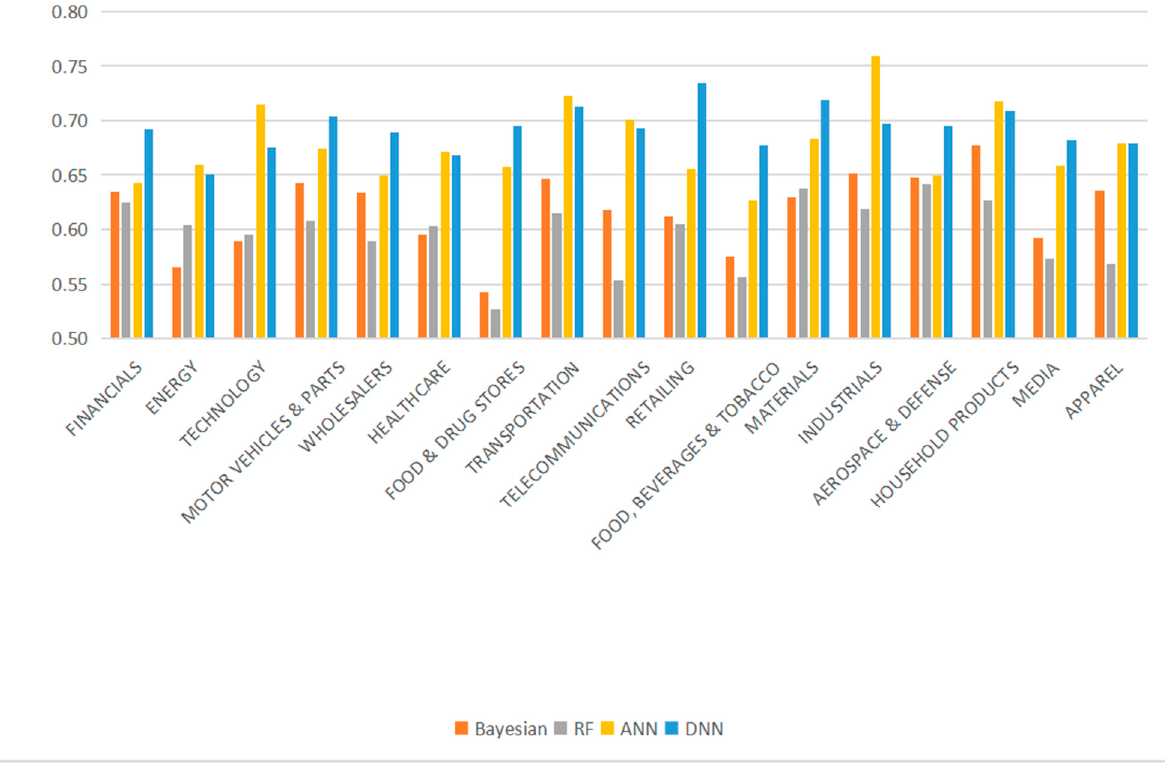
Figure 12. The evaluation of F1 score in industries.